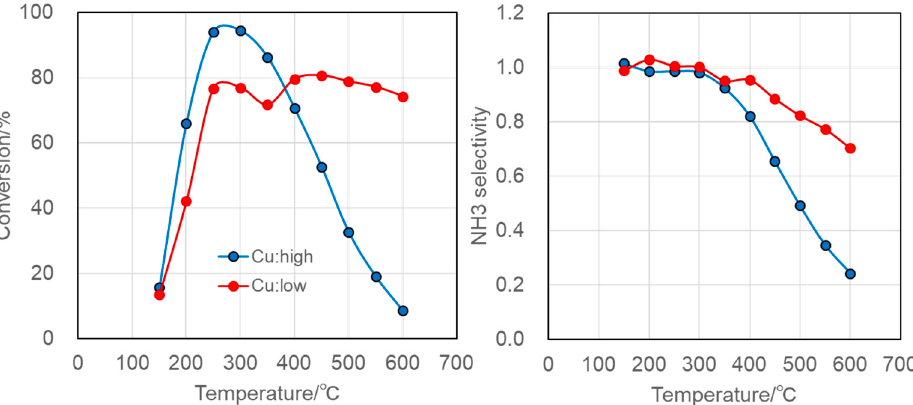
Figure 2. Catalytic performances of aged SSZ-13 with low (1.3 wt% Cu, Cu/Al = 0.30, red) and high (3.7 wt% Cu, Cu/Al = 0.89, blue) contents of Cu. ( Left ) NO conversions on hydrothermally-aged catalysts; ( right ) NH 3 selectivity for SCR.